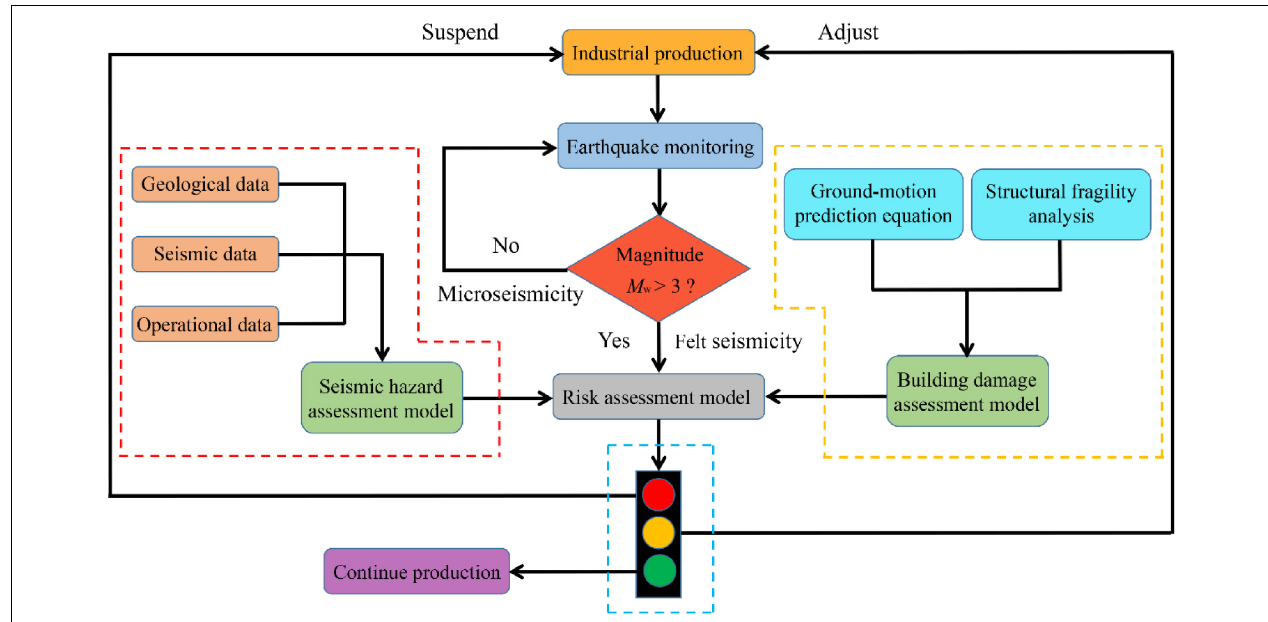
FIGURE 3 | A complete workflow of the traffic light system. The traffic light system needs to make decisions based on the results of the risk assessment model, which consists of a seismic assessment model and a building damage assessment model. The judgment basis for the former model is magnitude, while that for the latter model is ground